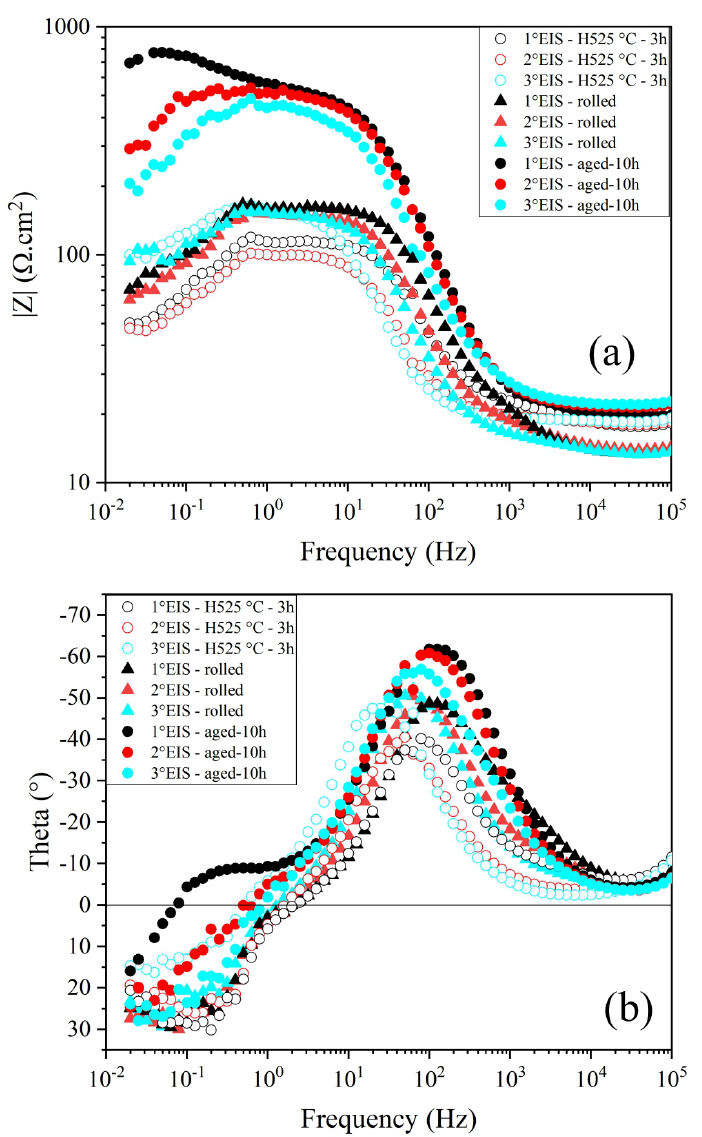
Figure 9. ( a ) Bode curves and ( b ) phase angle of H525 ◦ C-3 h, rolled and aged-10 h specimens in